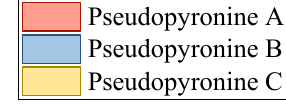
Figure 4. Reduction effects of sub-MIC concentrations of pseudopyronine A, B and C on mature biofilm of S. aureus . Data are presented as mean ± SD, n = 3, ** p < 0.01, compared to the control group.